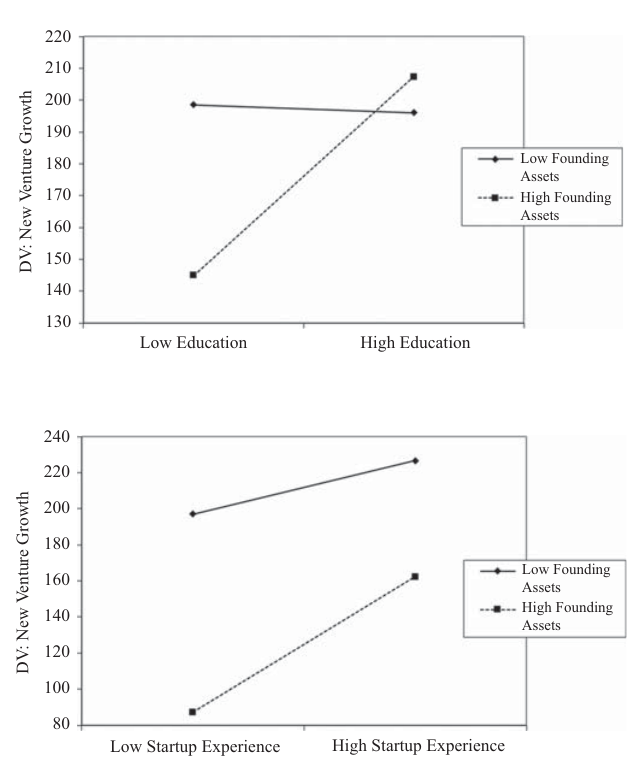
Figure 2. Interaction between startup experience and founding